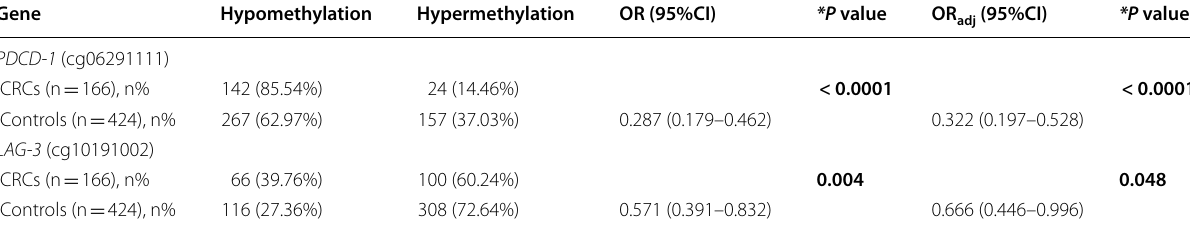
CRC, colorectal cancer; CI confidence interval; OR odds ratio; OR adj , adjusted for age, gender * P values < 0.05 were considered statistically significant and were indicated in bold